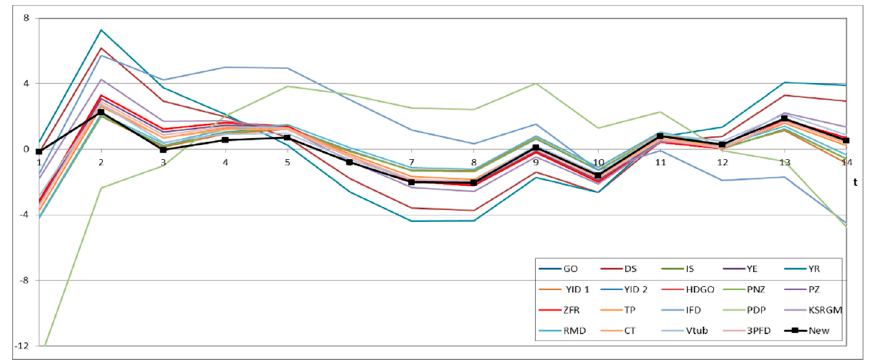
Figure 2. Relative error value for all models in Table 1 for dataset #1.